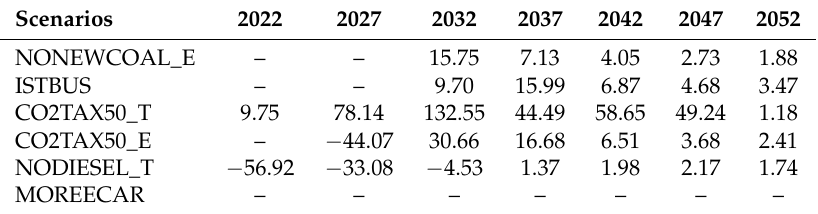
Table 11. Overall CO 2 abatement costs by scenario.